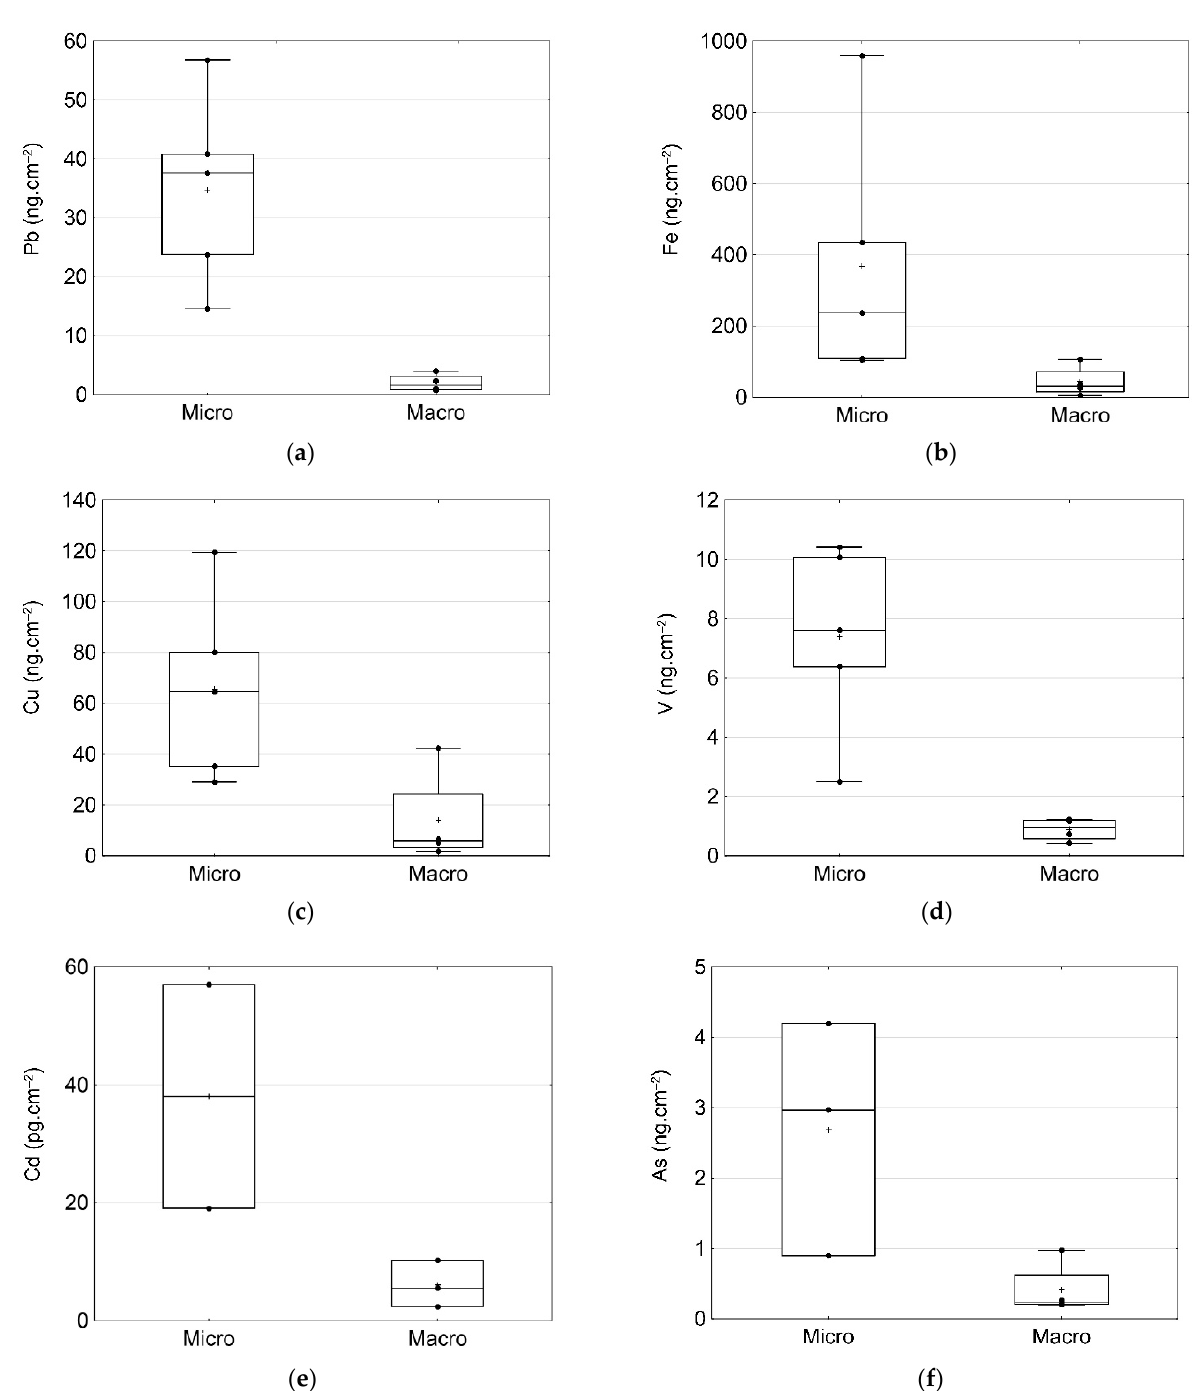
Figure 4. Boxplot of trace metal concentrations normalized over the surface of microplastics (Micro) and macroplastic (Macro) sampled in Genova. The average value is represented with a cross, the median is represented by an horizontal line while raw data is represented by black dots. The box length is defined as the interquartile range. ( a ) Pb, ( b ) Fe, ( c ) Cu, ( d ) V, ( e ) Cd, ( f ) As.